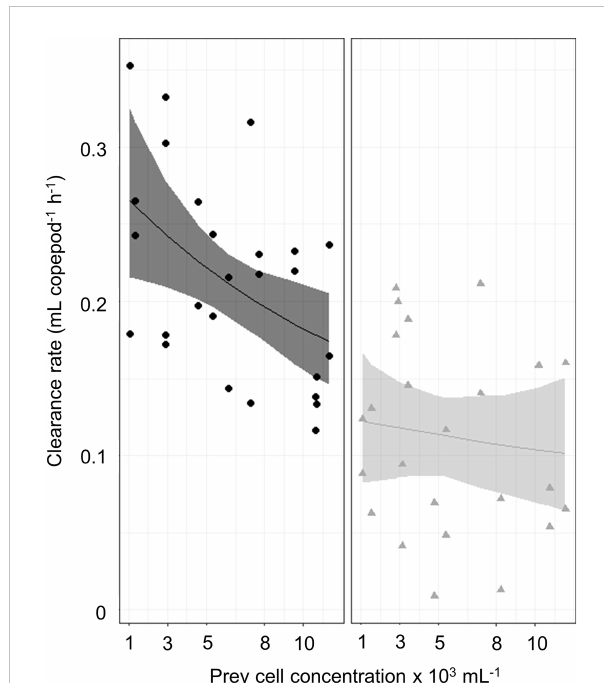
FIGURE 4 Clearance rates under ambient sound and harbor noise conditions fi tted to the Rogers random predator equation. The x-axis shows the initial phytoplankton prey cell concentrations (continuous variable) from min 1042 to max 11563 cells ml − 1 . The y-axis presents the clearance rate that is de fi ned as the volume of water from which cells are removed by feeding copepods (ml copepod − 1 h − 1 ) calculated after Frost (1972). The left panel shows the clearance rate under ambient aquarium sound conditions and the right panel the clearance rate under playback harbor noise exposure. The jittered dots are presenting all values in the data. The 97.5% con fi dence intervals were calculated using a bootstrap method in R version 3.4.4 (R Core Team,